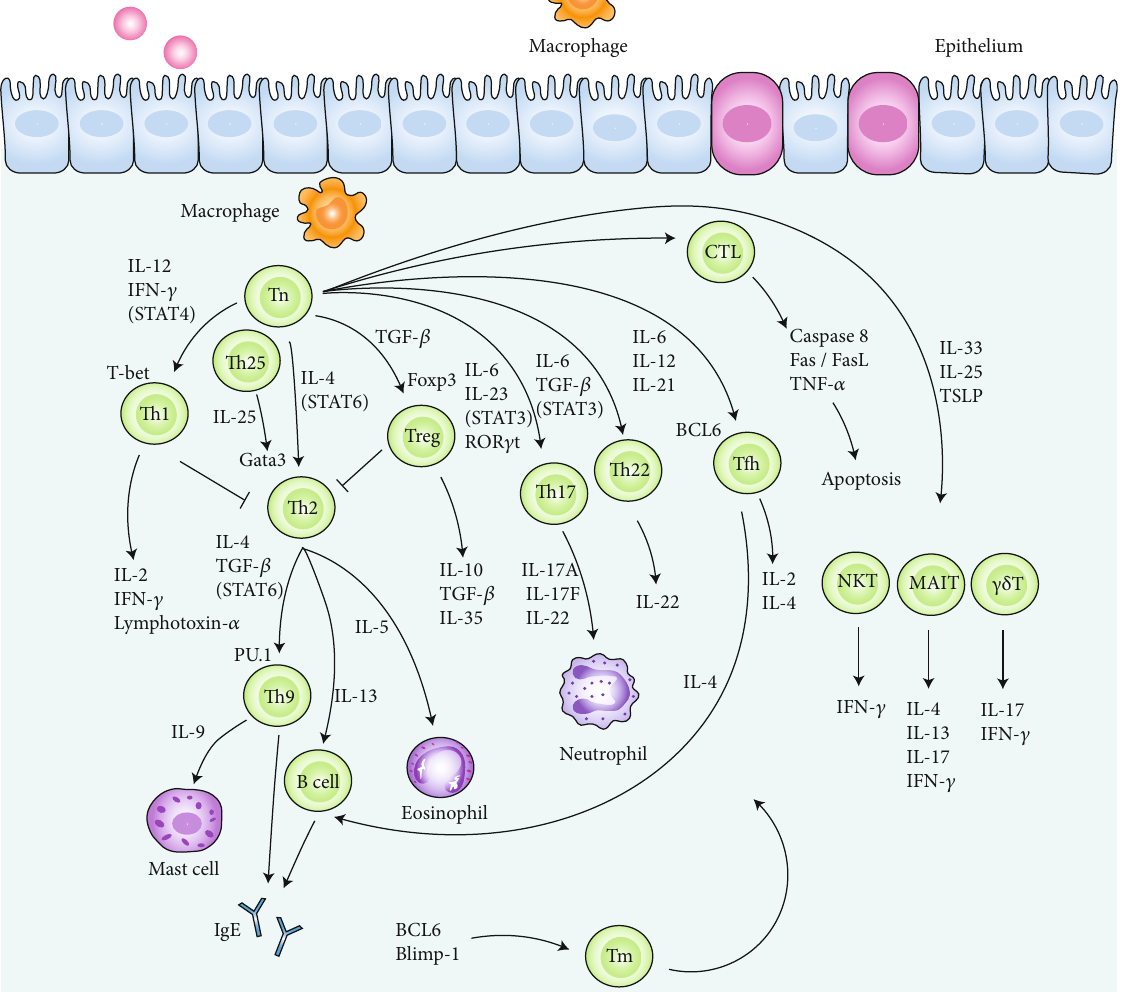
Figure 1: Imbalance of T cells in asthma pathogenesis. In response to allergens, the naïve T (Tn) cells are activated by the macrophages and tend to di ff erentiate into T helper (Th) 1, Th2, Th17, Th22, Th9, Th25, T regulatory (Treg), T follicular helper (Tfh), natural killer T (NKT), mucosal-associated invariant T (MAIT), γδ T cells, cytotoxic CD8 + T lymphocytes (CTLs), and memory T (Tm) cells. They secrete cytokines to activate and recruit the eosinophils, neutrophils, mast cells, and B cells. The arrows represent the secretions from these cells, a ff ecting the progression of asthma. The transcriptional factors T-bet, Gata3, RAR-related orphan receptor (ROR) γ t, Foxp3, and PU.1 are necessary to Th1, Th2, Th17, Treg, Th22, and Th9 cell activation. The signal transducer and activator of transcription (STAT) signals are involved in the process. Besides, caspase 8 and the Fas/FasL pathway are related to cell apoptosis mediated by